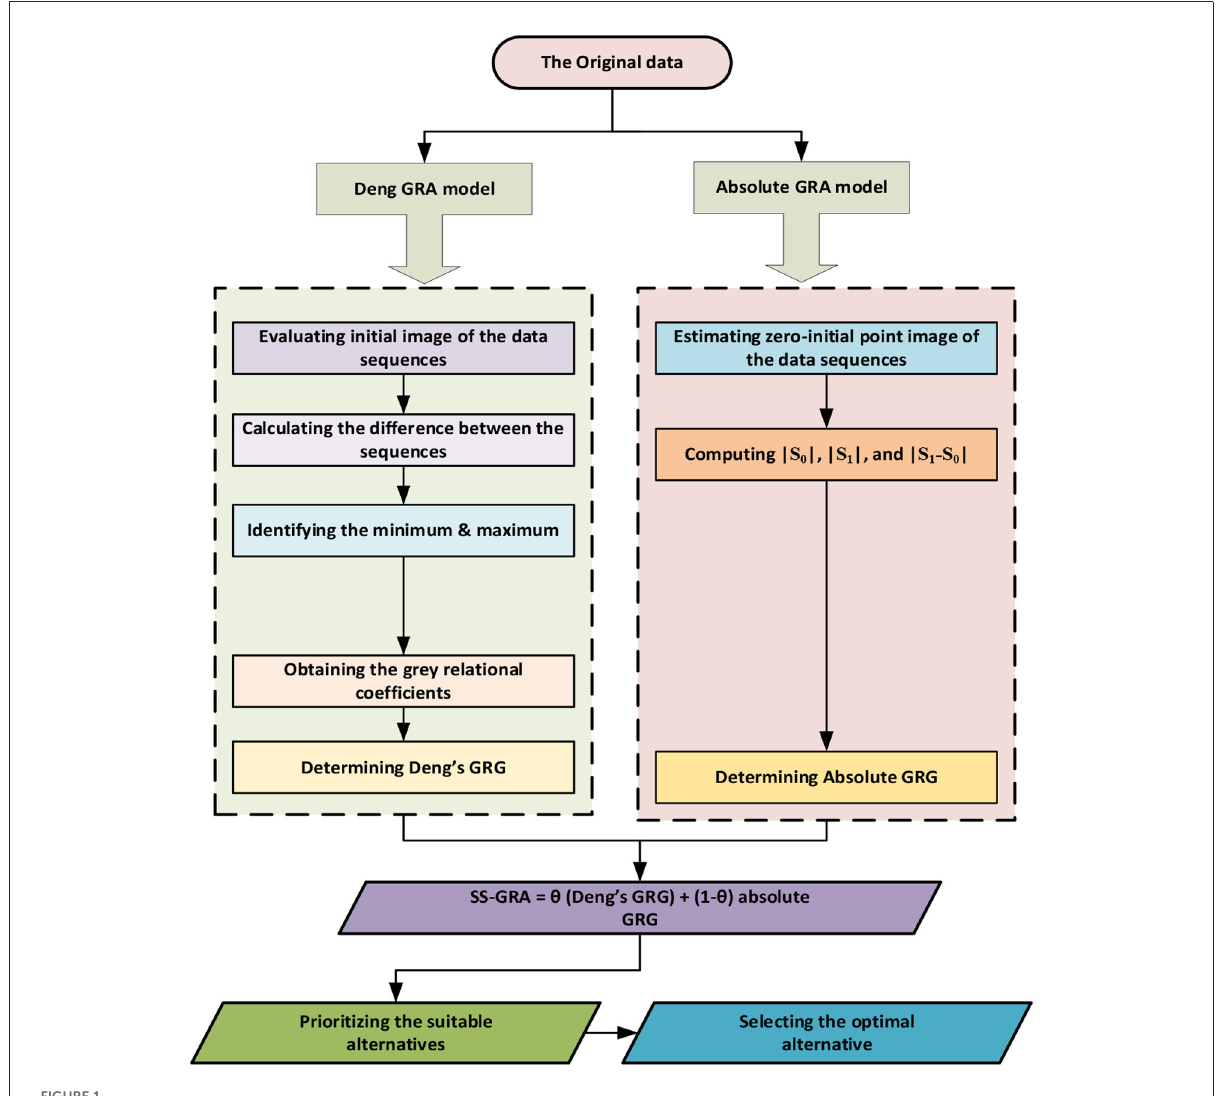
FIGURE1 The methodological roadmap of grey